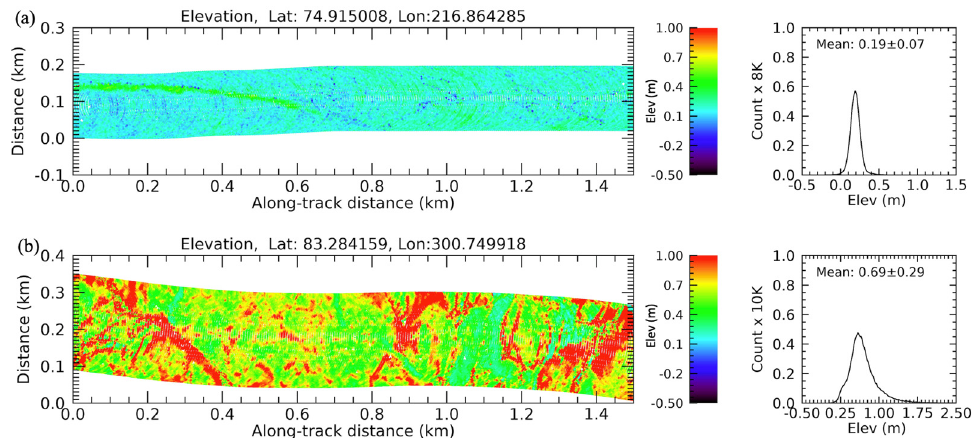
Figure 4. ( a ) Typical first-year flat thin ice and the histogram of a 1.5 km section, 21 April 2016. ( b ) Typical multi-year rough thick ice and the histogram of a 1.5 km section in central Arctic, 9 March 2017. The cross-track swath width is related to the ATM laser scan angle and airplane flight height. Latitude and longitude are the center locations of the two 1.5 km sections.